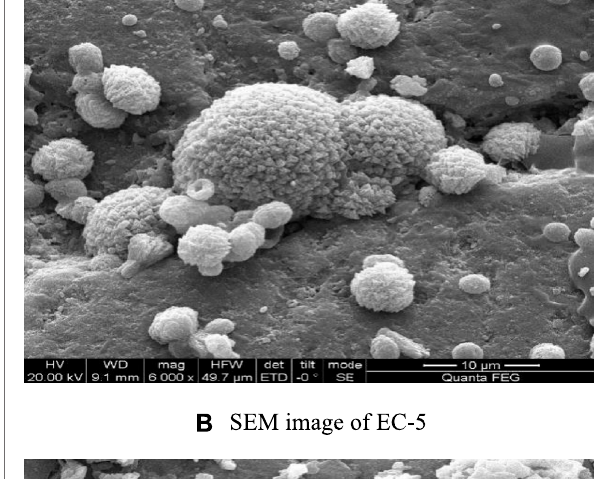
FIGURE 3 | XRD and SEM images of sand treated with different calcium sources. (A) XRD patterns of sand with different treatment methods; (B) SEM image of EC-5; (C) SEM image of ER-5. E represents enzyme-induced carbonate precipitation (EICP), C represents calcium ion solution extracted from concrete, R represents calcium chloride solution and 5 represents the number of treatment.